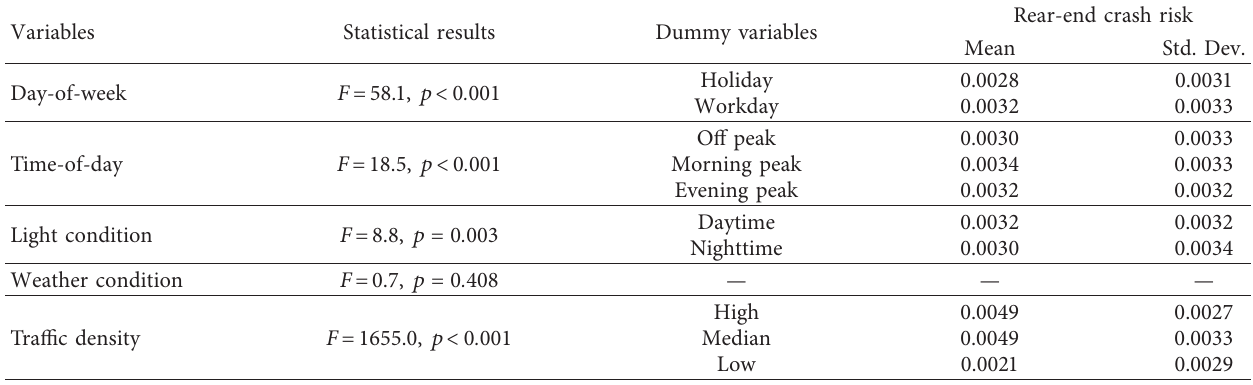
Table 5: Significant main effects for rear-end crash risk.